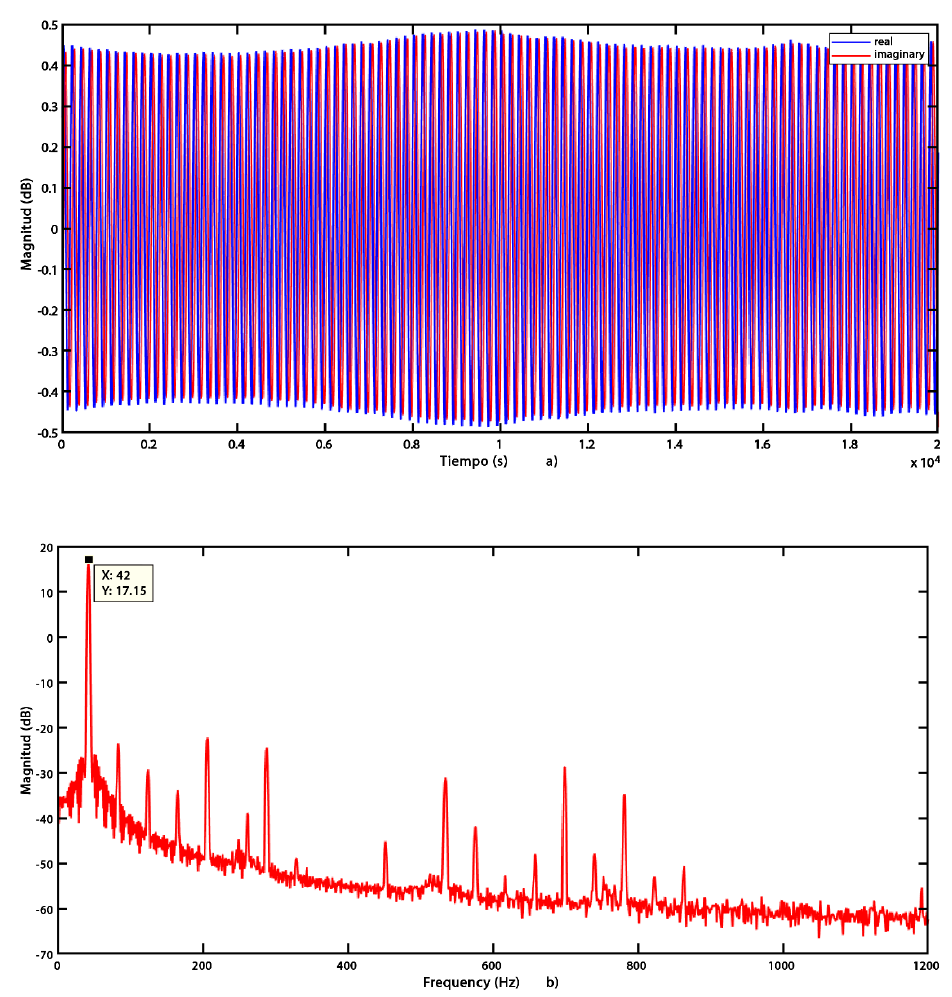
Figure 7. HT for the electrical generator signal. ( a ) Real and imaginary part of the signal, ( b ) HT PSD using the FFT.